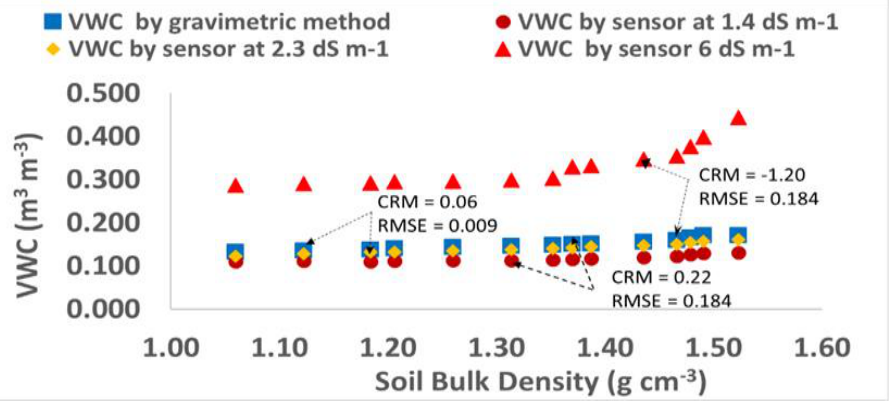
Figure 7. Influence of soil texture on sensor measurements.